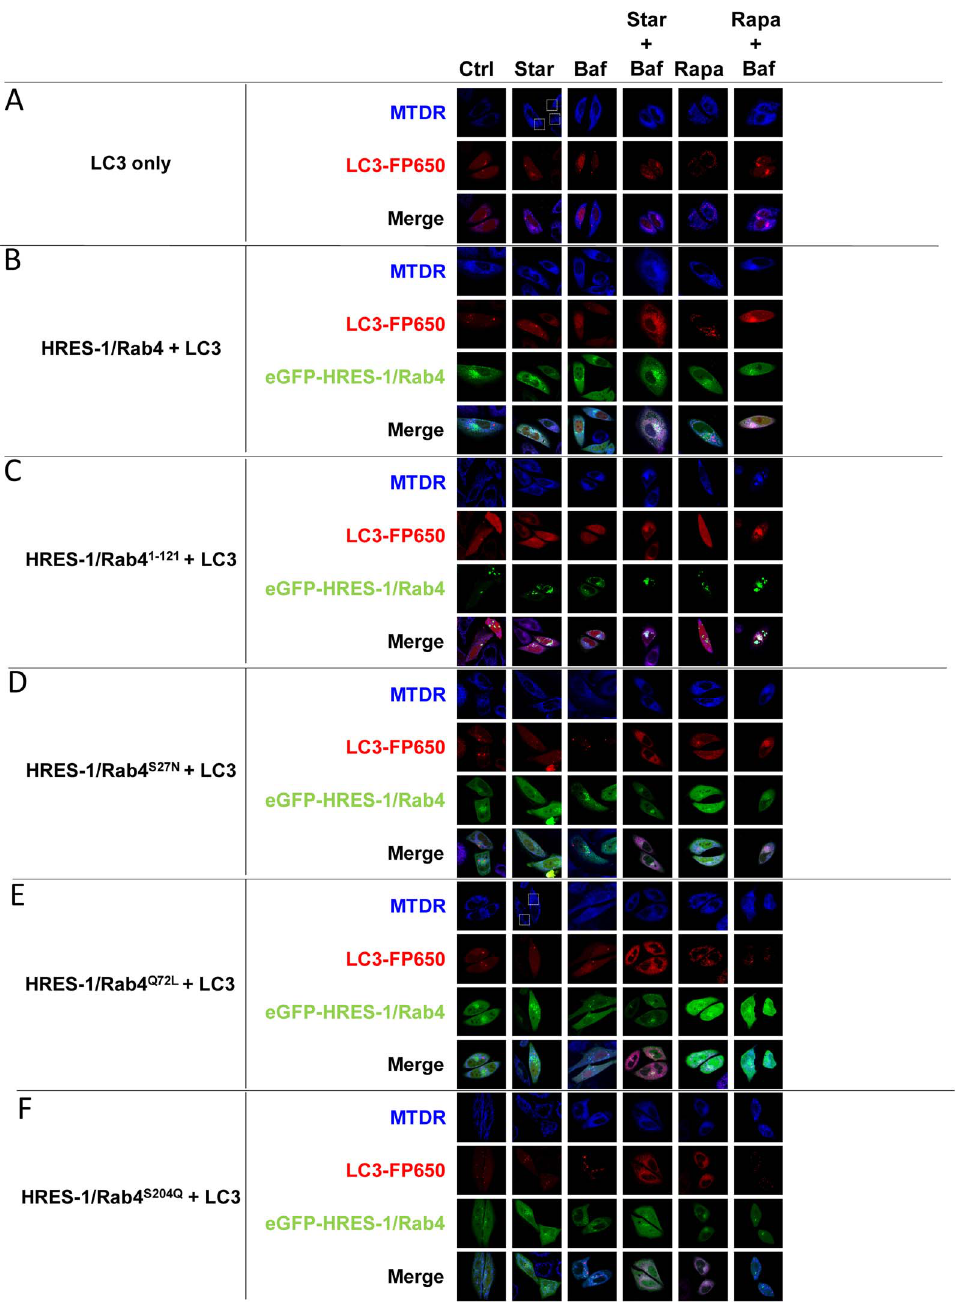
Figure 4. Confocal microscopy of HRES-1/Rab4, mitochondria, and LC3 + autophagosomes in HeLa cells under starvation (Star) and treatment with rapamycin (Rapa) and bafilomycin A1 (Baf). eGFP-tagged HRES-1/Rab4 isoforms were identified by green fluorescence. Mitochondria were stained with MTDR and visualized by blue fluorescence. LC3 + autophagosomes were visualized by red fluorescence of FP650-LC3. Individual and composite color channels are shown for each experimental condition. A, HeLa cells were transfected with FP650-LC3 alone. B, HeLa cells were transfected with FP650-LC3 and eGFP-tagged HRES-1/Rab4. C, HeLa cells were transfected with FP650-LC3 and eGFP-tagged HRES-1/ Rab4 1–121 . D, HeLa cells were transfected with FP650-LC3 and eGFP-tagged HRES-1/Rab4 S27N . E, HeLa cells were transfected with FP650-LC3 and eGFP-tagged HRES-1/Rab4 Q72L . F, HeLa cells were transfected with FP650-LC3 and eGFP-tagged HRES-1/Rab4 S204Q . The areas showing the formation of mitochondrial tubular networks are delineated by white dotted rectangles in panels A and E.